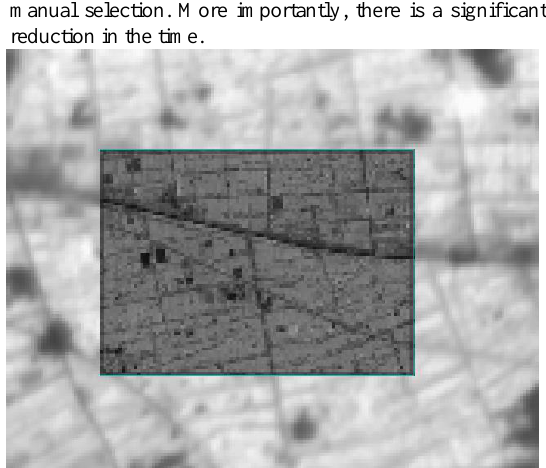
Figure 1. The image registration